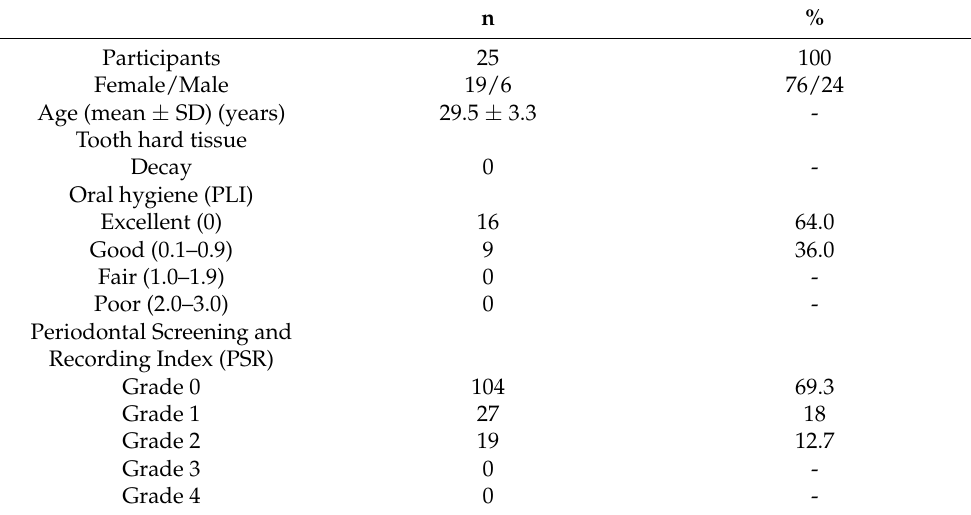
Table 3. The study participants’